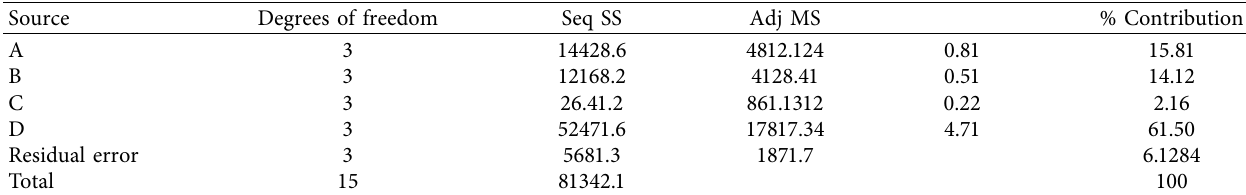
Table 7: Means-variance analysis.